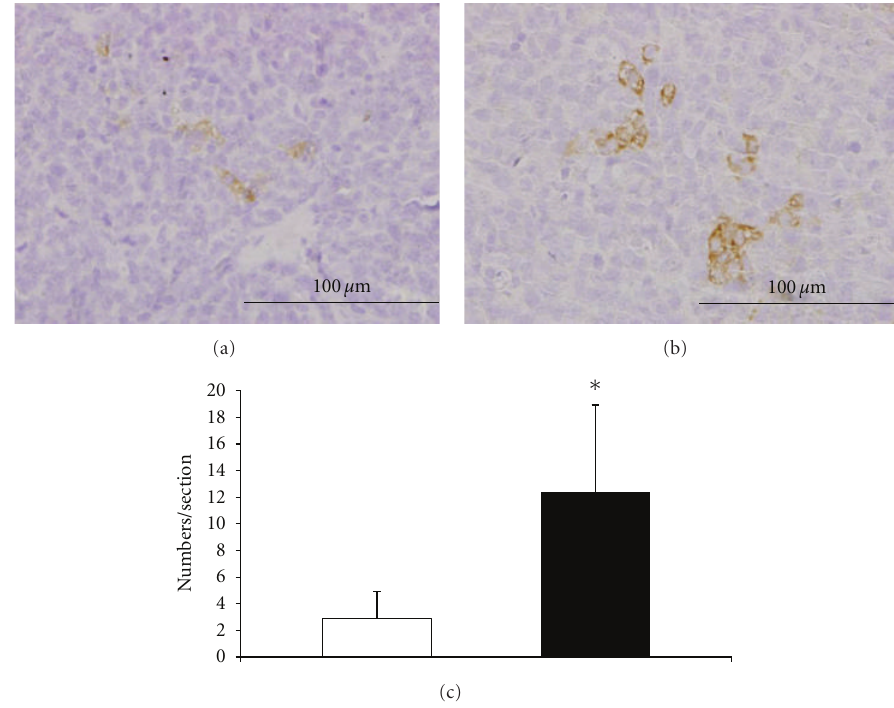
Figure 8: Immunohistochemistry of CD68 in BJMC338 tumor (a) and BJMC3879 tumor (b) at 4 weeks postinoculation. The density of macrophages in BJMC3879 tumors was significantly higher than that in BJMC338 tumors ( ∗ P < 0 . 001)